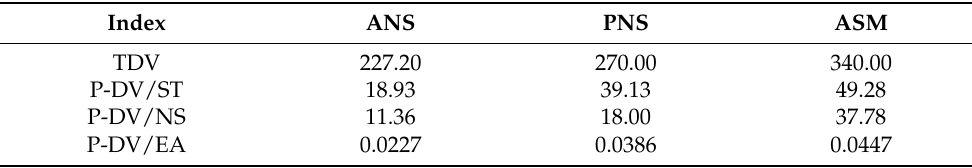
Figure 6. The results of data collection time in different communication rates. (4) Data value under different indicators: Based on the current growth stage of crops, under the constraints of sensing time, the data values of 10 sensing environmental param- eters were scored by a percentage system. Then, the total value of sensing data (TDV), the data value of sensing time per unit (P-DV/ST), the data value of sensing node per unit (P-DV/NS), and the data value of effective sensing area per unit (P-DV/EA) under different indicators were calculated for the data collected in the three schemes, and the obtained results are shown in Table 2. Table 2. The data value indicators of different